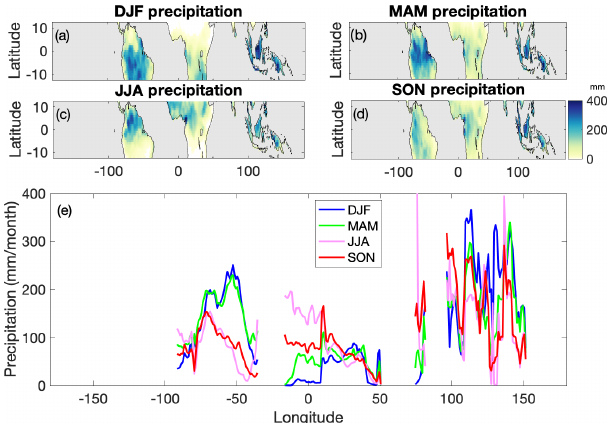
Figure 4. Seasonality of precipitation based on GPCP in the tropics in December–January–February (a) , March–April–May (b) , June– July–August (c) , and September–October–November (SON) and its latitudinal average (e)